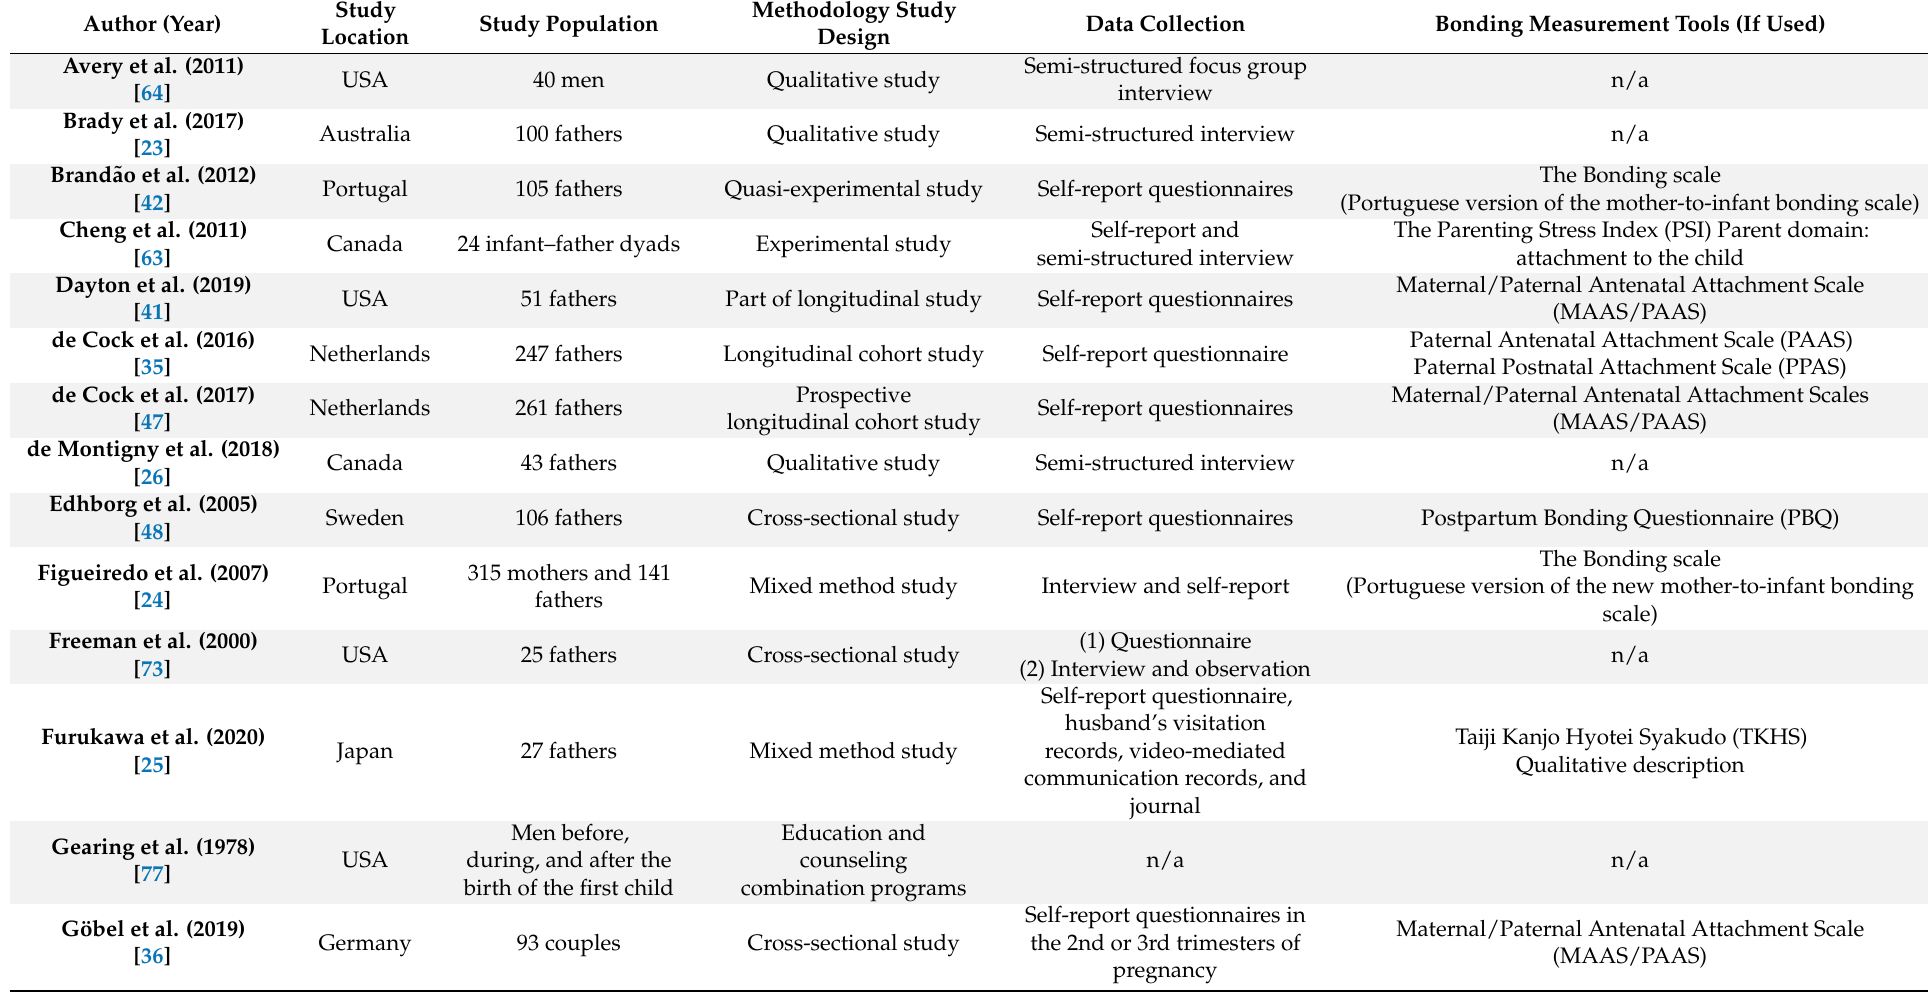
Table 1. All inclusion studies in this